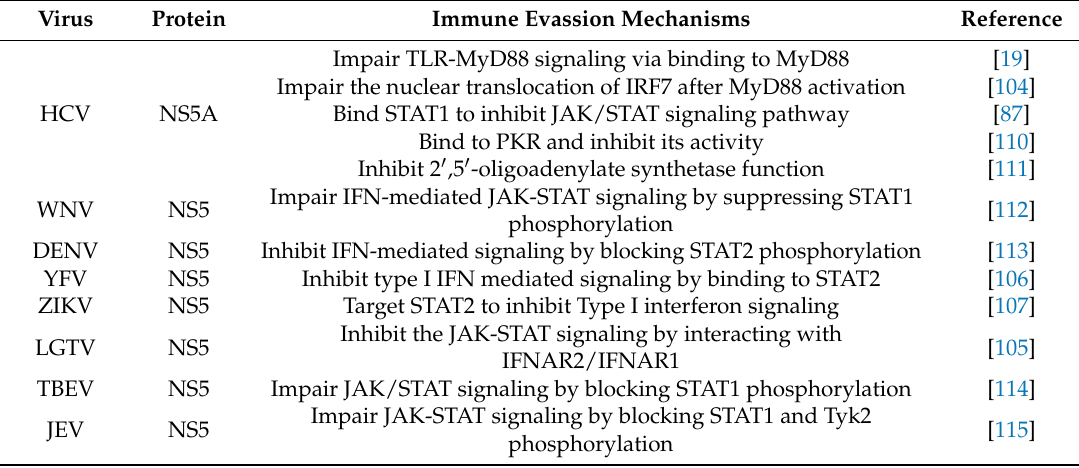
Table 4. Immune evasion by flaviviridae NS